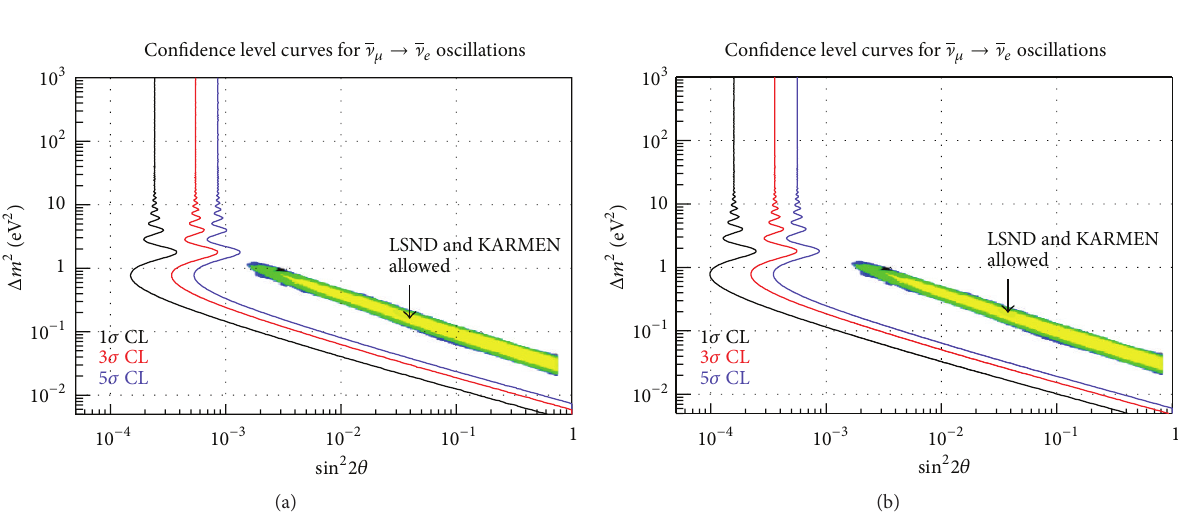
Figure 21: The OscSNS sensitivity curves for the simulated sensitivity to ] 𝜇 → ] 𝑒 oscillations after two (a) and six (b) calendar years of operation. Note that OscSNS has more than 5𝜎 sensitivity to the LSND allowed region after 2 years of data